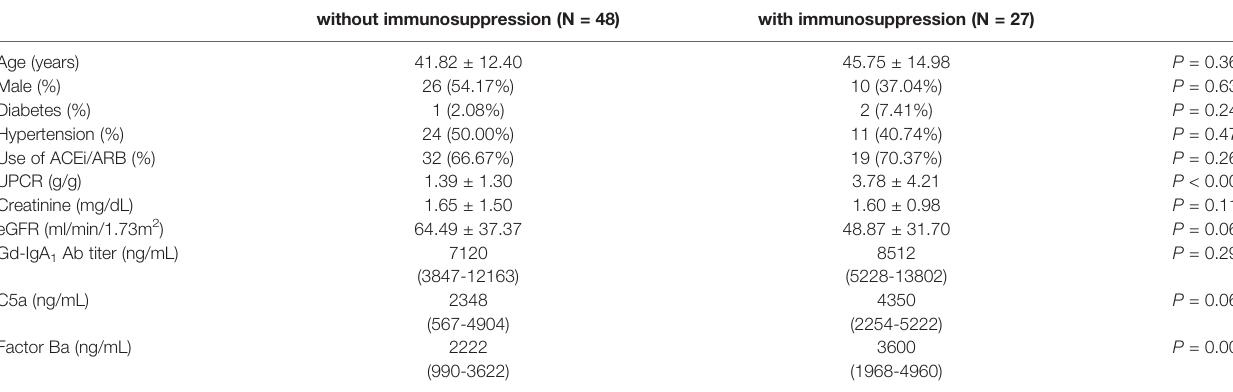
TABLE 2 | Comparisons of baseline characteristics among IgAN patients with and without